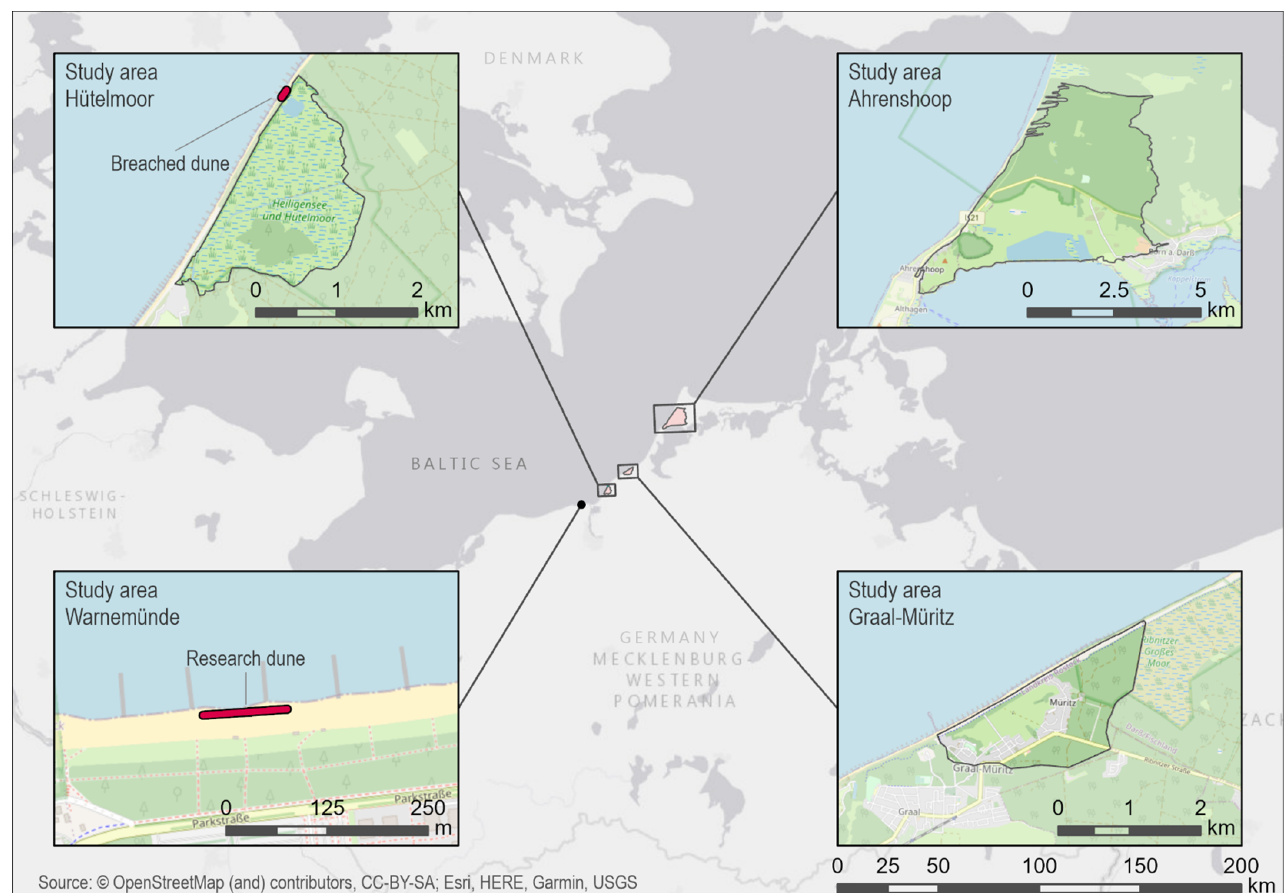
Figure 3. Overview of the PADO study areas (Source: GeoBasis-DE/M-V/OpenStreetMap and contributors, CC-BY-SA).